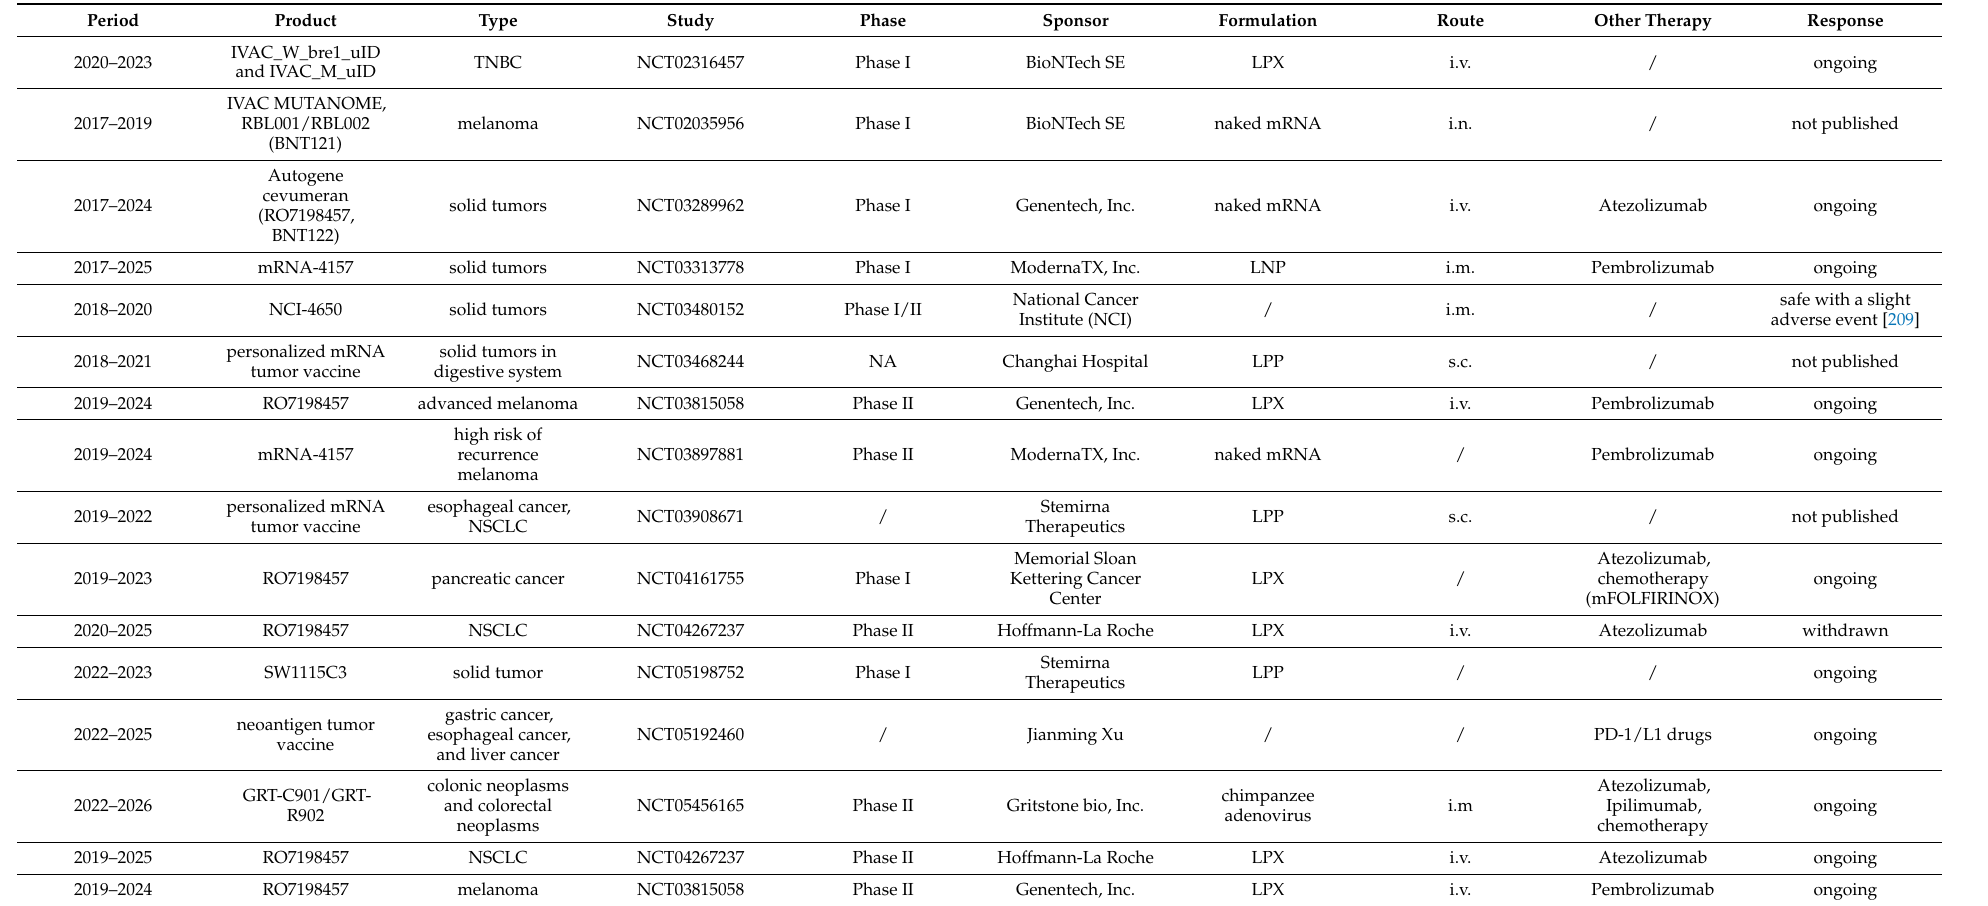
Table 1. Clinical trials of neoantigen